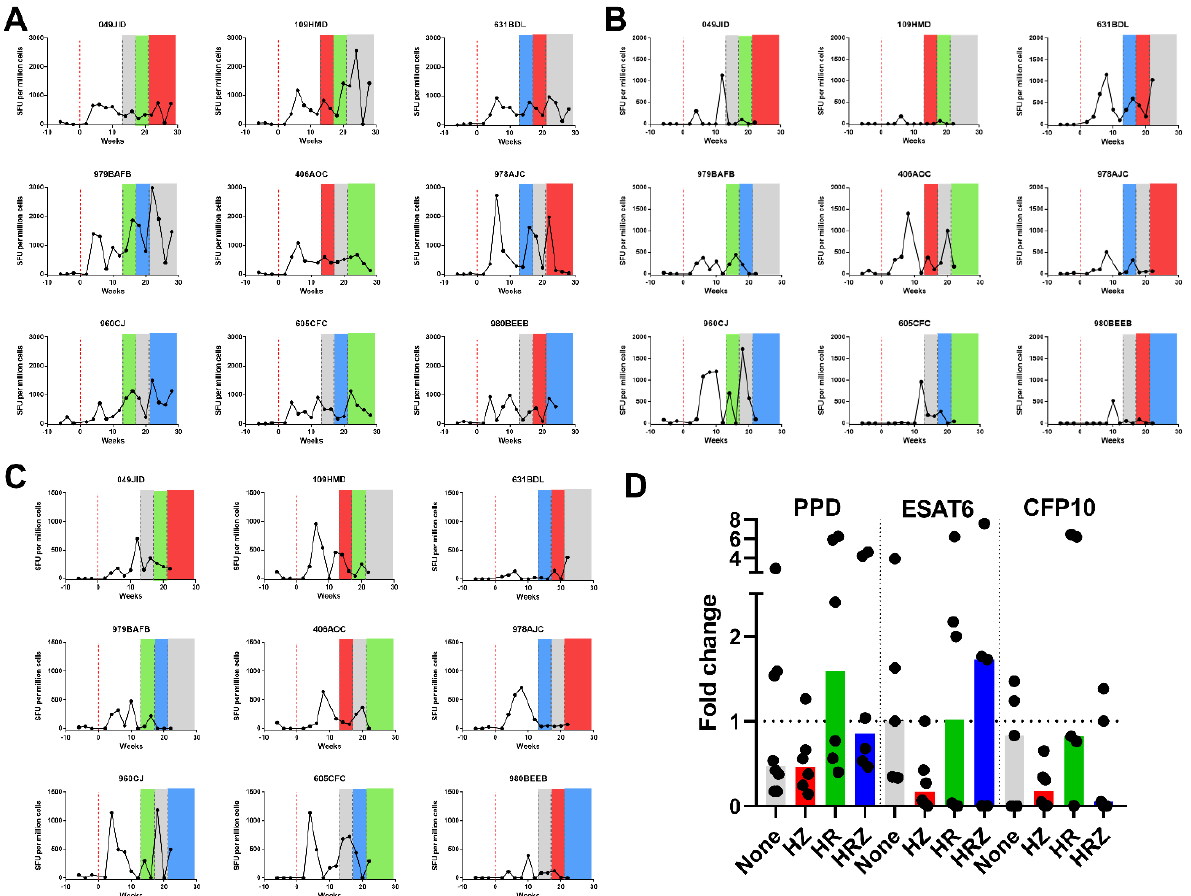
Figure 4. Frequencies of M. tb antigen specific IFN- γ producing SFU measured by ELISPOT in the peripheral blood from cynomolgus macaques infected with M. tb H37Rv during treatment with combinations of HR, HZ or HRZ: ( A ) PPD-specific SFU, ( B ) ESAT6-specific SFU, ( C ) CFP10-specific SFU, ( D ) Fold change in SFU/million cells between the start and end of treatment. Red = HZ, green = HR, blue = HRZ, gray = no treatment.